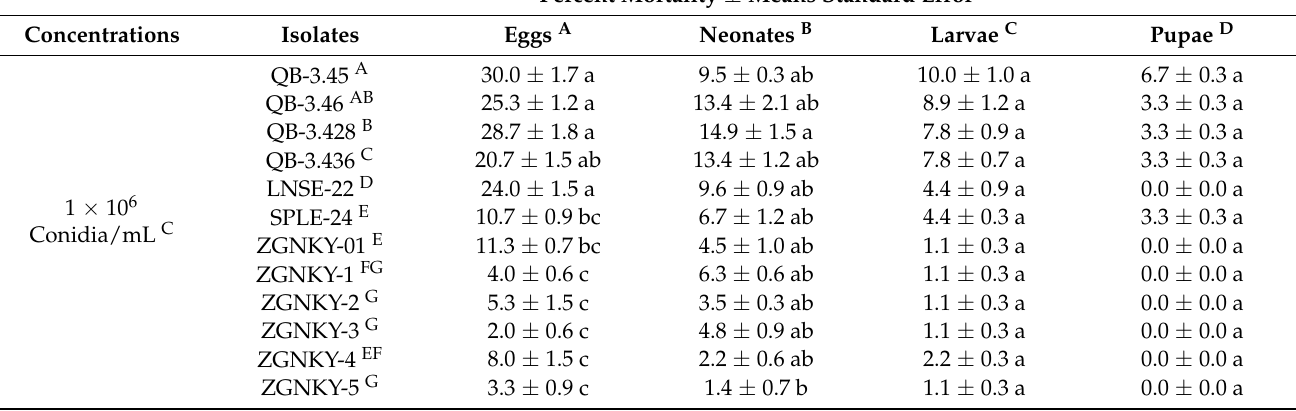
Table 2. Percent mortality (Means ± SE) of immature stages of FAW treated with different concentrations of isolates of Beauveria bassiana. Percent Mortality ± Means Standard Error Eggs A Neonates B Larvae C Pupae